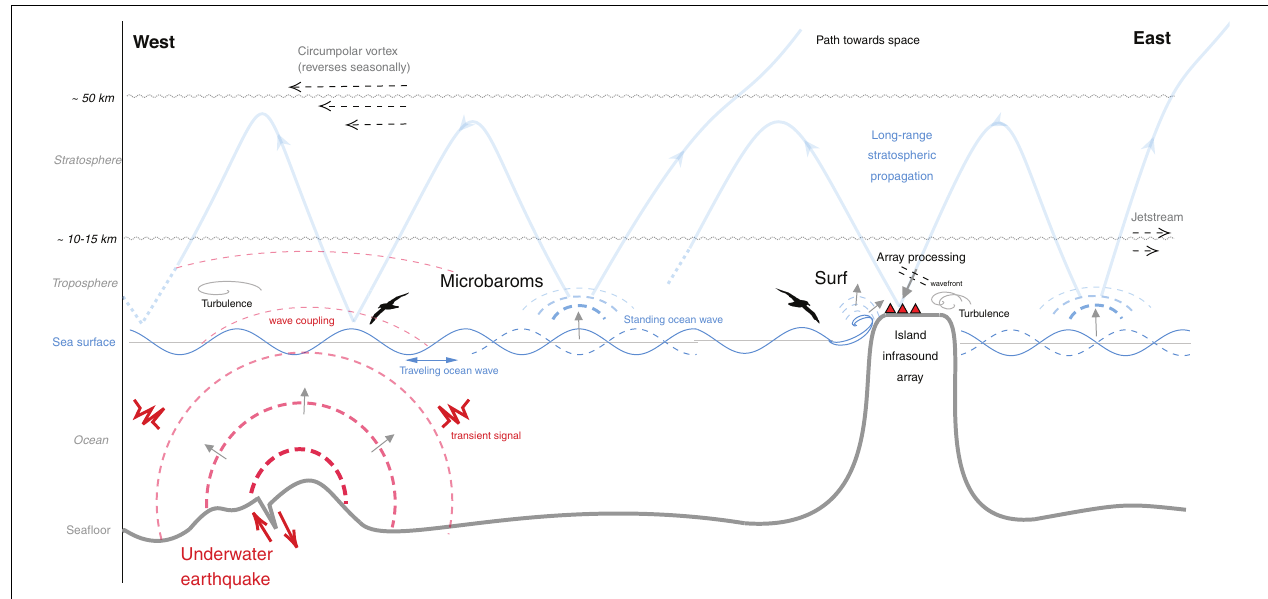
FIGURE 2 | A schematic representation of the marine infrasonic wavefield. The ocean produces continuous acoustic background noise (i.e., microbaroms and surf; depicted in blue). Microbaroms can propagate over long distances downwind (i.e., from east to west) in the stratospheric waveguide. In the upwind direction, microbaroms are not guided and propagate toward space. The wind direction changes seasonally. Surf infrasound is generated near coastlines and does not propagate over long distances. Transient acoustic signals (red) also occur in the marine environment, e.g., following an underwater earthquake. These vibrations can couple into the atmosphere. Besides the acoustic signals, the wavefield also consists of turbulence, which may mask signals of interest. Array processing techniques can be used to detect coherent acoustic waves in a turbulent